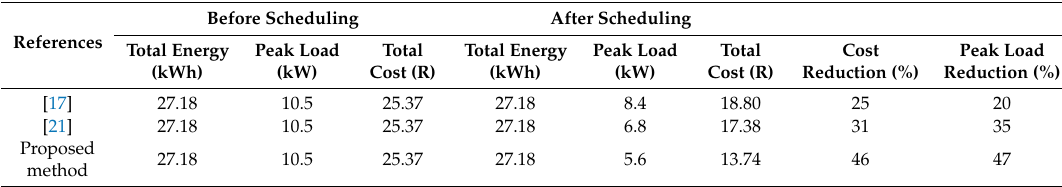
Table 11. Comparison